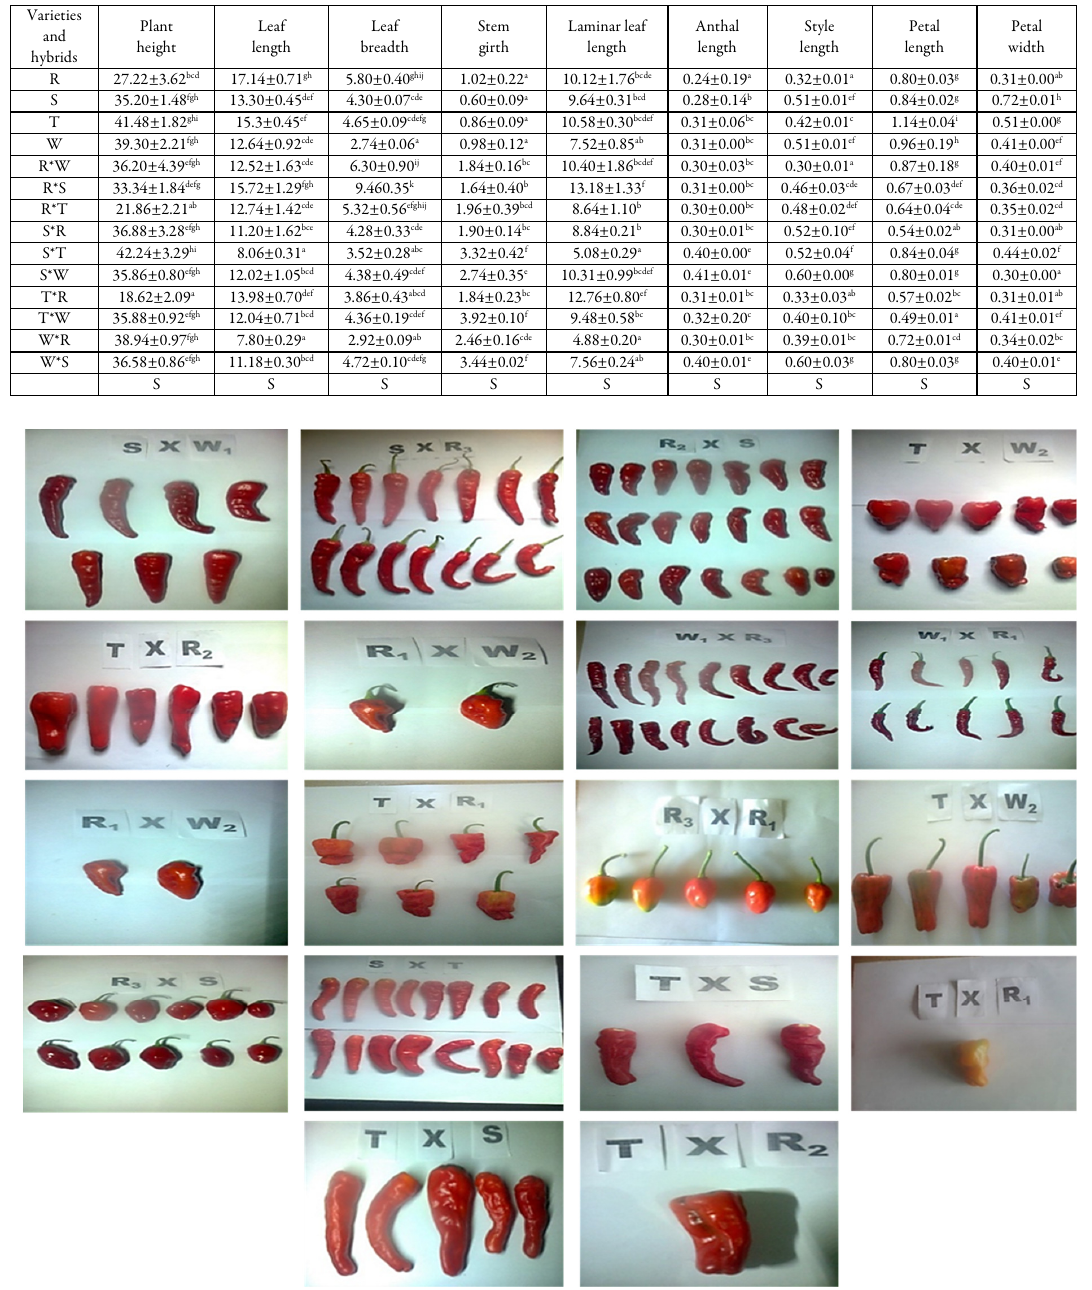
Figure 3. F 0 hybrid